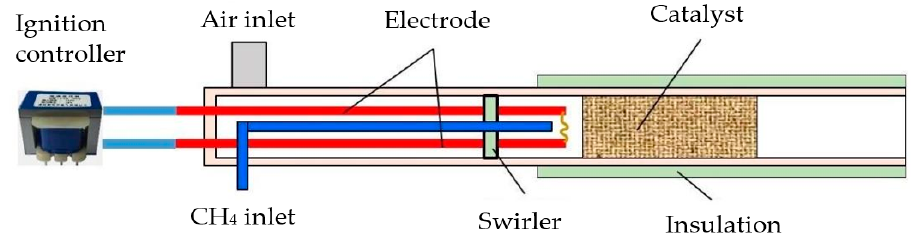
Figure 2. Principle of downhole catalytic combustion.